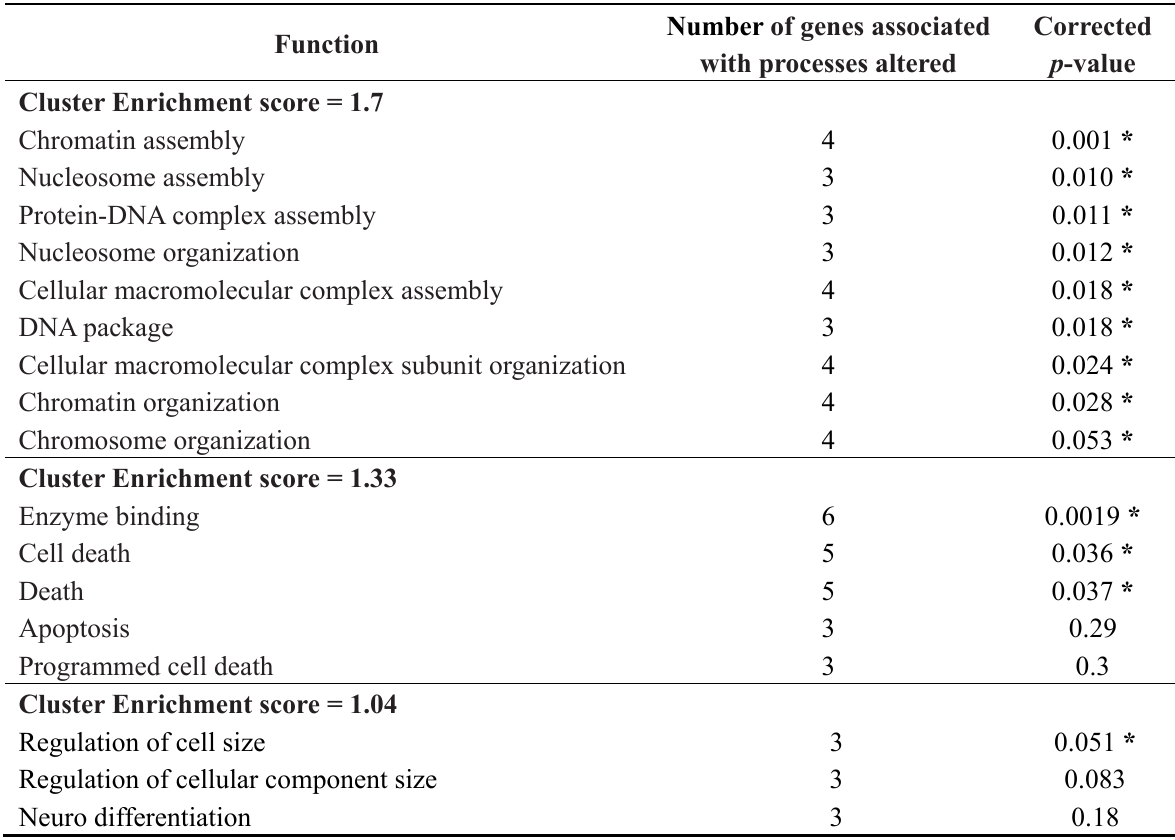
Table 1. Gene set enrichment analysis. Cells were exposed to 1 µM paraoxon for 4 days in RA-induced differentiation medium. All genes with statistically ( p < 0.05) altered expressions and a fold change higher than 2 or lower than 0.5 were uploaded for further analysis in the DAVID bioinformatics (Nature. Available online: http://www.nature.com/nprot/ journal/v4/n1/abs/nprot.2008.211.html (accessed on 26 December 2013). * p -value < 0.05. Number of genes associated Corrected Function with processes altered p -value Cluster Enrichment score =